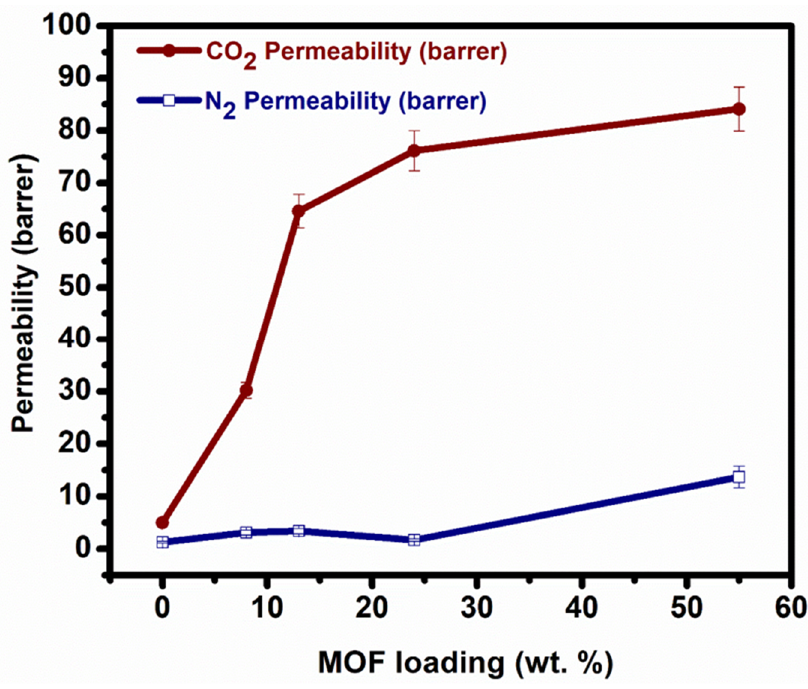
Figure 7. A dependence of CO 2 and N 2 gas permeability behavior of PVAm-PVA-UiO-66-NH 2 MMM with different UiO-66-NH 2 loading amounts.